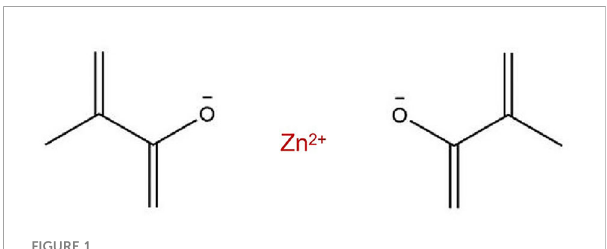
FIGURE 1 Molecular structure of zinc